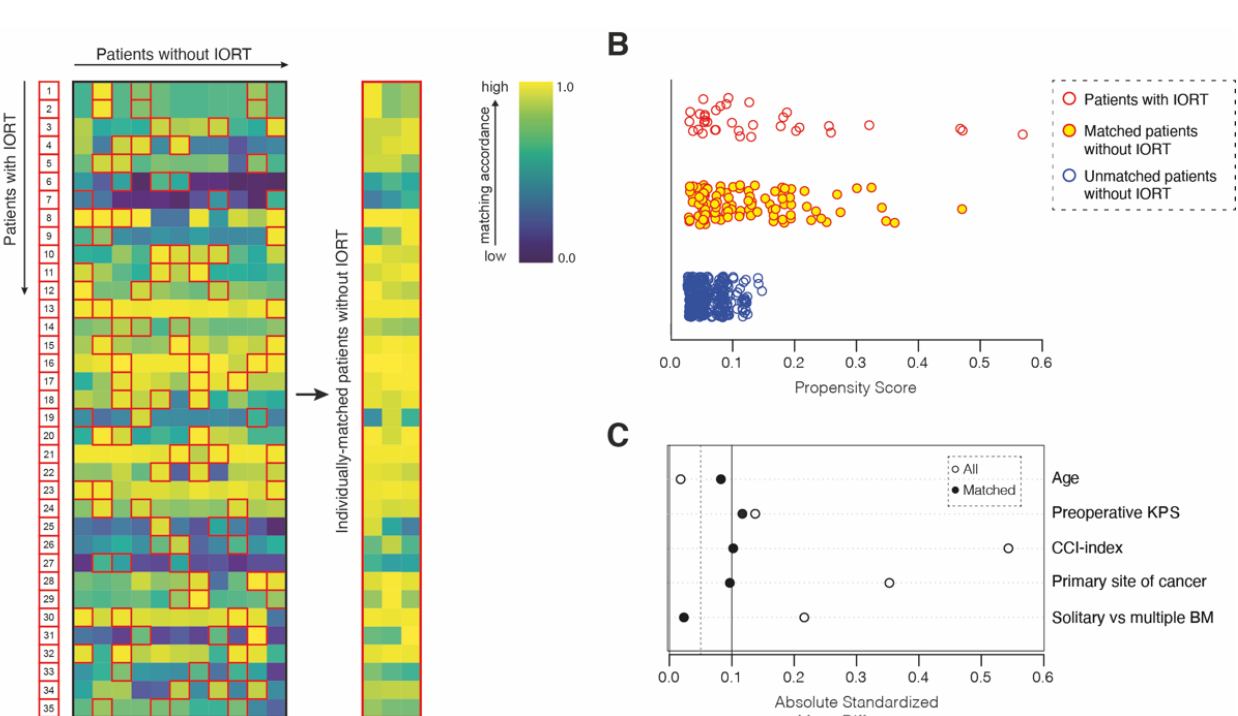
Specific CSCs 0 (0) Values represent the number of patients unless indicated otherwise (%). CSCs, cranial surgery-related com- plications; HAC, hospital-acquired conditions; IORT, intraoperative radiotherapy; No., number; PSIs, patient safety indicators.